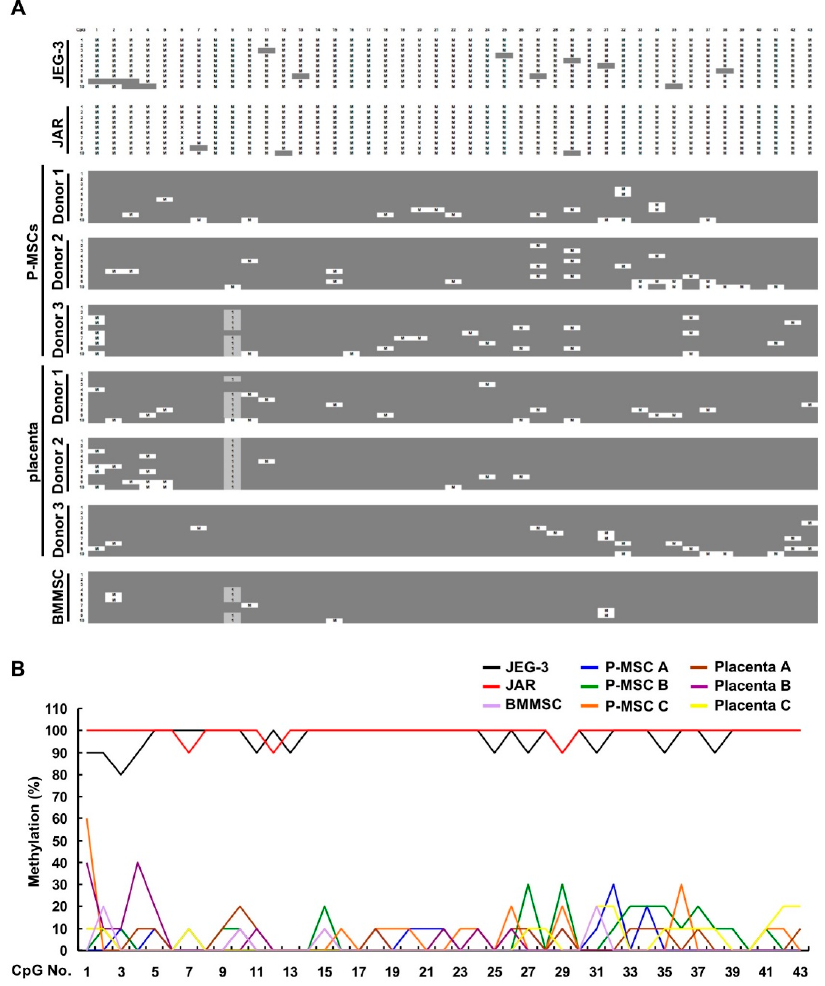
Figure 5. CpG sites within the cell body of HLA-G are strongly hypomethylated in all human MSCs and placental tissue but nearly 100% methylated in both choriocarcinoma cell lines. ( A ) Region II (from ATG to + 1303; 441 bp containing 43 CpG sites) of genomic DNA obtained from JEG-3, JAR, P-MSCs (3 donors), BMMSCs (1 donor), and placenta (3 donors) were sequenced after bisulfite modification with 10 clones of PCR products sequenced for each sample. Gray boxes, unmethylated CpG site; M, methylated CpG site. X, missing CpG site (no.6); 1, CCGG → CCCG (CpG site no.9). ( B ) Quantification of the percentage of individual CpG site which are methylated within the HLA-G gene fragment spanning 441 bp downstream of ATG in each cell / tissue type. Methylation (%), percentage of total methylation per CpG